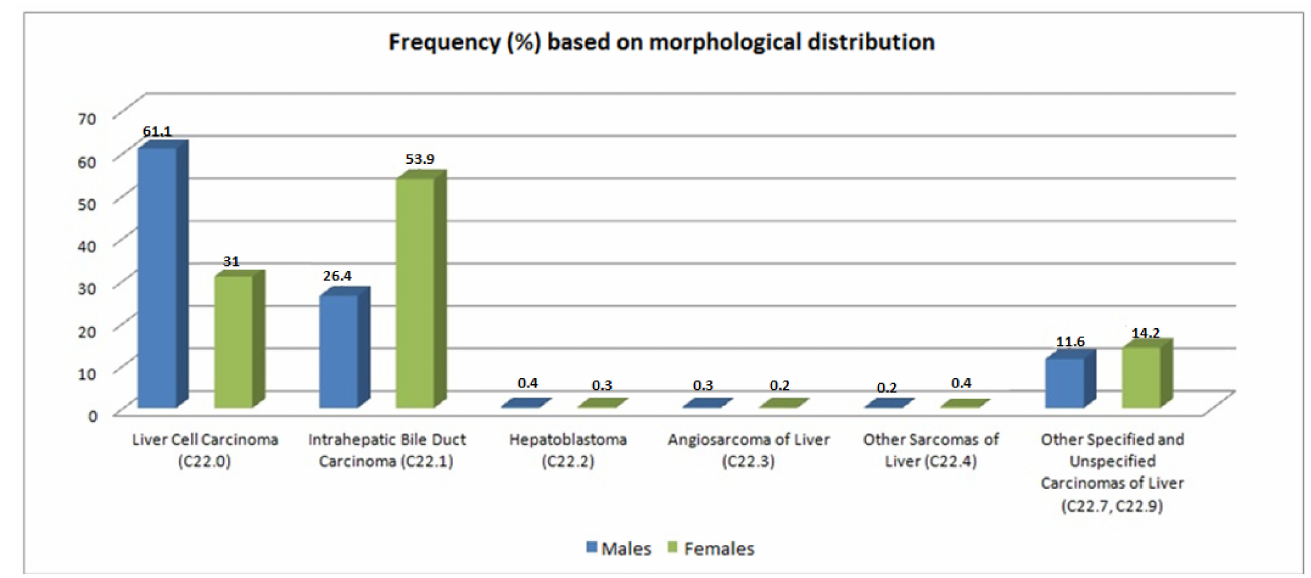
Figure 3. Frequency (%) of cases based on morphological